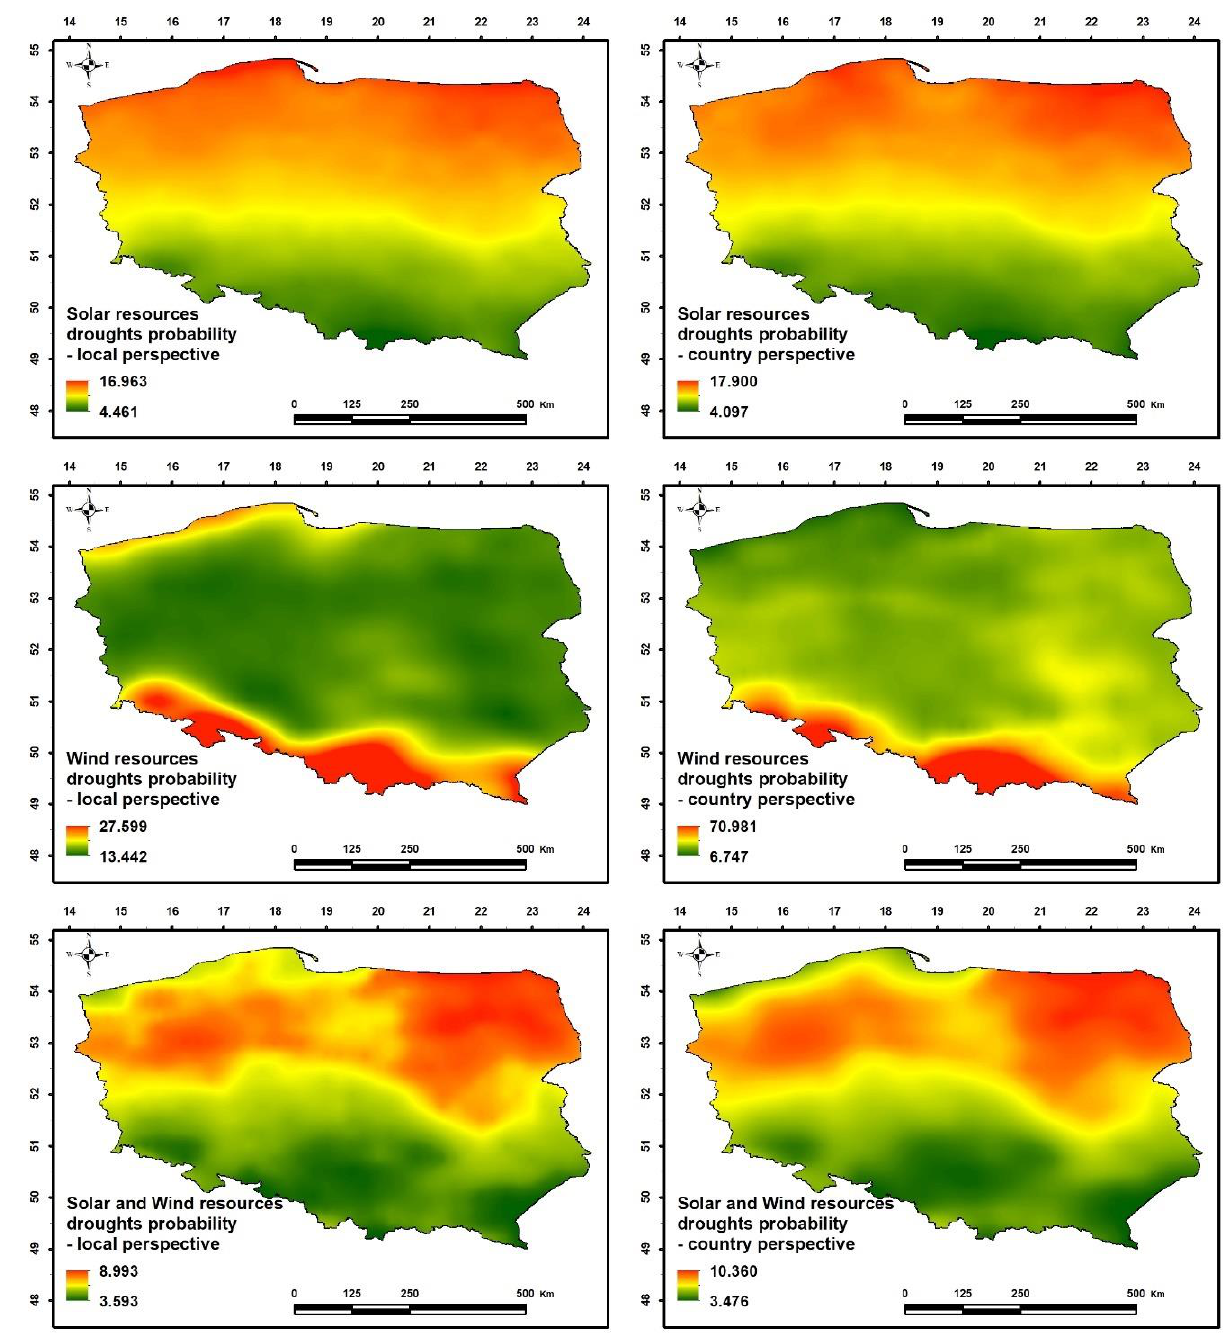
Figure 16. Probability [%] of local and national ‘resources droughts’ based on daily sums of resources availability, 1980–2019 To better represent ‘resources drought’ events, two locations have been considered, one in central Poland near the Bełchat ó w (51.2 ◦ N, 19.4 ◦ E) brown coal power station and open-pit mine, and a second in Łeba on the Baltic coast (54.6 ◦ N, 17.50 ◦ E). The selection of locations was not random. First, we selected the Bełchat ó w region because in 2030 the owner will probably begin phasing out the power station blocks. This location is very favorable for developing other power stations due to its location in central Poland and its existing strong transmission capacity (Bełchat ó w brown coal power station’s nameplate capacity exceeds 5 GW). The second location is characterized by one of the best wind resources; Pomerania voivodeship (where Łeba is located) also has one of Poland’s highest installed capacities in wind